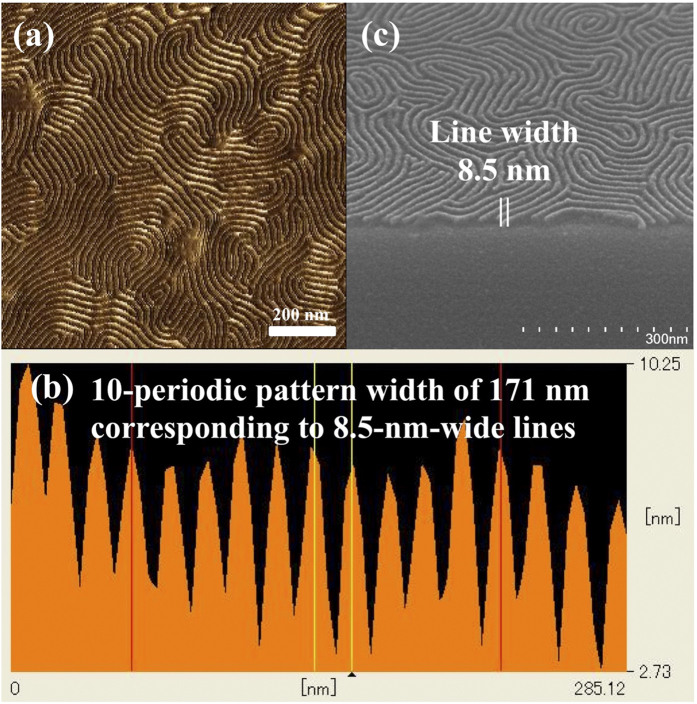
(a) AFM phase image of a 32-nm-thick (=2.0L0) PS100-b-PMHxOHS25 film after annealing at 130 °C for 1 min and O2-RIE for 90 s. The etching rate for PS is 0.25 nm/s under these conditions. (b) AFM height cross section of the image in (a). (c) SEM image of (a).